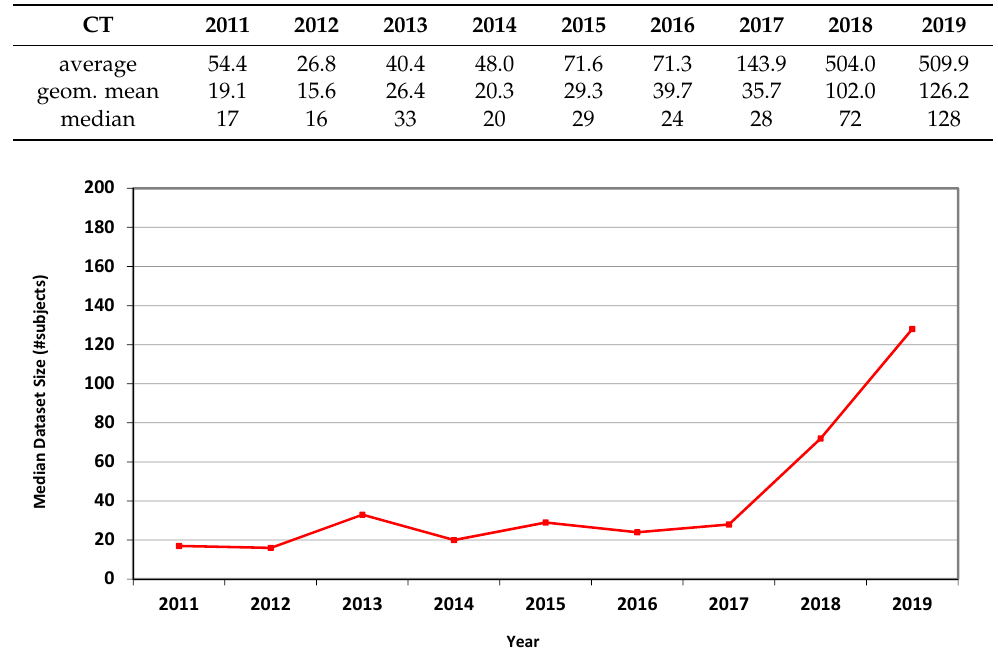
Figure 2. Median size of datasets used in MICCAI articles related to CT in each of the years 2011– 2019.